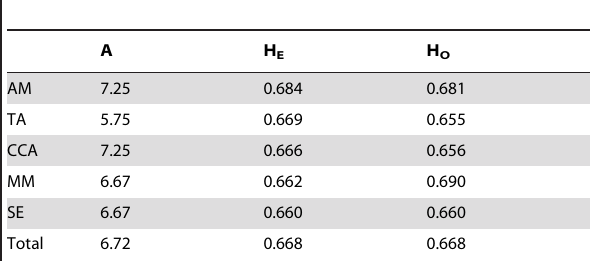
Table 4. Measures of genetic diversity averaged across the number of samples and 12 microsatellite loci for each of the populations sampled in southern Kenya and northern Tanzania; A is the average number of alleles across all loci, H E is the expected heterozygosity and H O is the observed